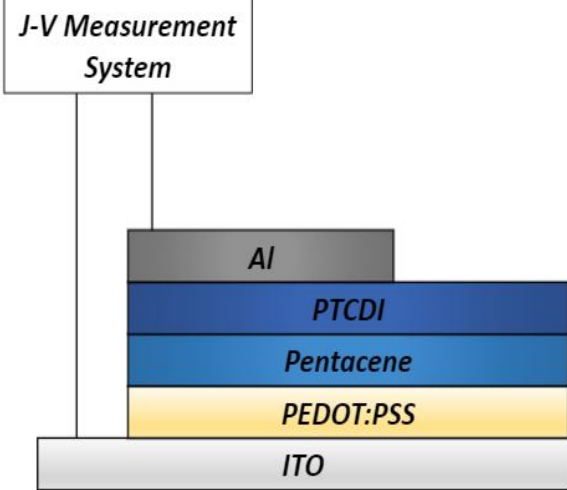
Figure 10. Illustration of the solar cell’s schematic structure.